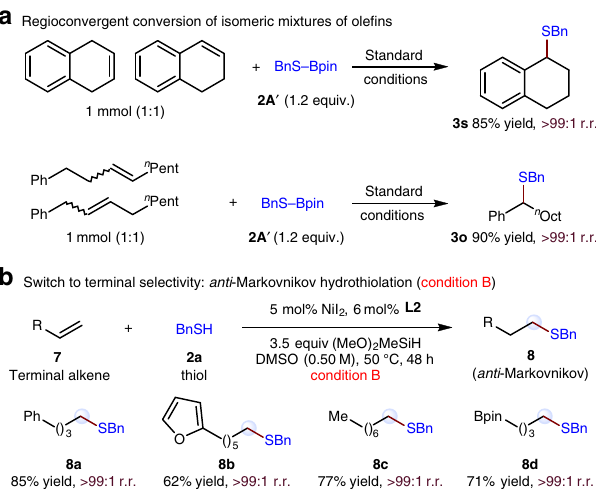
Fig. 10 Regioconvergent and expanded site-selectivity experiments. a Regioconvergent conversion of isomeric mixtures of ole fi ns. b Switch to terminal selectivity: anti -Markovnikov